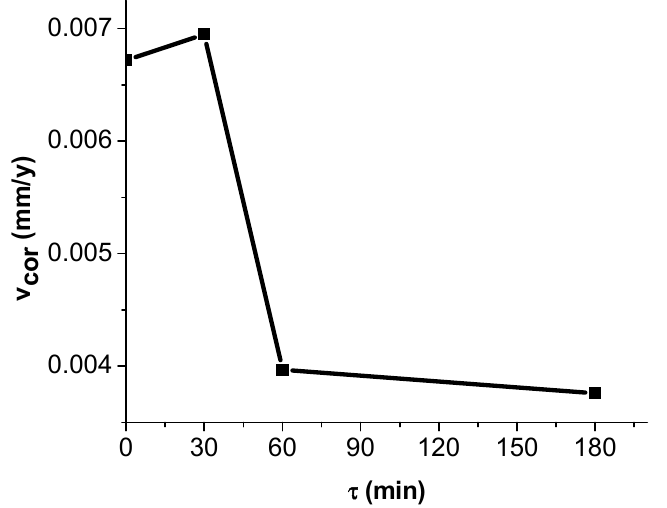
Figure 8. The evolution of corrosion resistance over time for the multicomponent equimolar AlAgCuNiSnTi